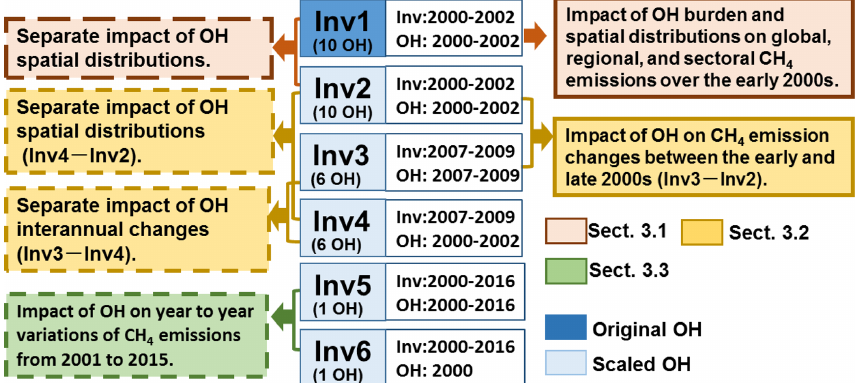
Figure 1. A diagram showing inversion experiments (Inv1–Inv6) performed in this study. For each experiment, “Inv” gives the time period of inversion, and “OH” gives the time period of the OH fields used in the inversion. Inv1 is performed using the original OH field, whereas Inv2–Inv6 are performed using scaled OH fields. The colored boxes on the left and right show analyses of inversions we did to examine the OH impacts on inverted CH 4 emissions. The brown, yellow, and green text boxes correspond to analyses presented in Sect. 3.1–3.3,